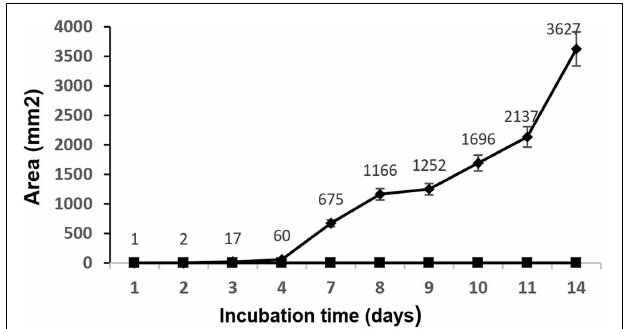
FIGURE 3 | Mean values (mm 2 ) and standard deviation of the injured area by A. niger in mango fruit. (cid:7) , samples infected with A. niger spores; (cid:4) , samples inoculated with sterile phosphate-buffered